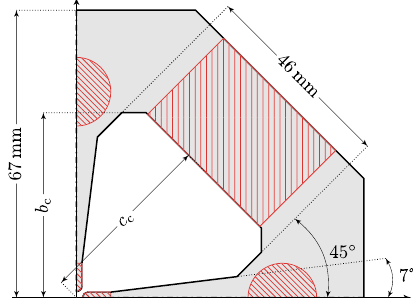
FIG. 24. Quadrant of the Carbon-RFQ cavity cross section with restrictions to the optimization highlighted in red.FIG. 22. Scan of the maximum transverse envelopes σ (a) x; max